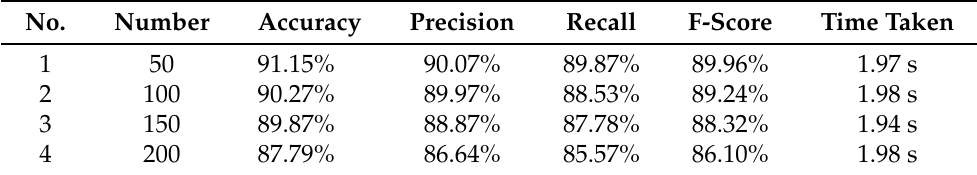
Table 5. Command type c Experimental results.